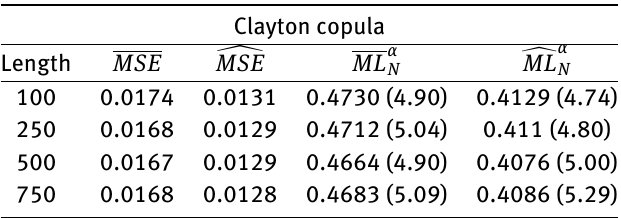
Table 3: Impact of estimation errors for the Clayton copula. From left to right we have: the length of the series, the mean squared error for the univariate and bivariate methods, and the mean length of prediction intervals for the univariate and bi- variate methods. The numbers in parenthesis are the percentage of observed values out of the prediction intervals. These val- ues are not significantly different from 5%, at the 95%